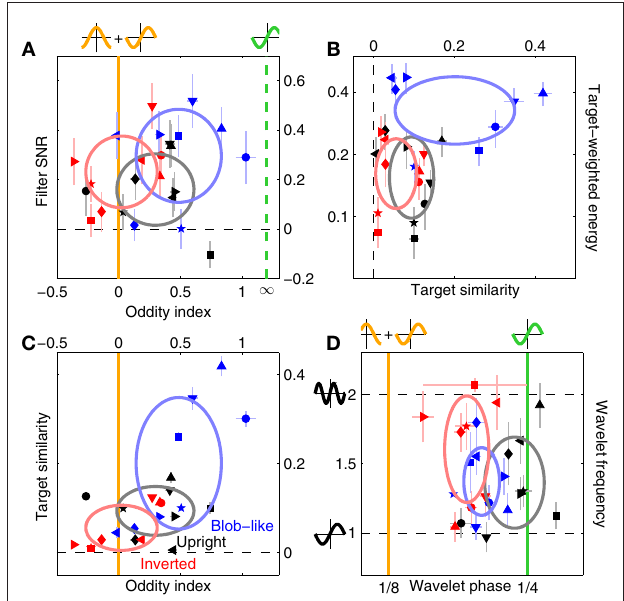
Figure 5 | Filter shape metrics. (A) Plots filter oddity (log-ratio between odd and even energy) on the x axis, versus filter signal-to-noise ratio (SNR) on the y axis (see Section 2.6 for definitions of these quantities). Vertical orange line indicates oddity index of 0, corresponding to equal odd and even content (see orange cosine + sine icon above line). Vertical green line indicates oddity index of ∞ , corresponding to a noiseless odd function (see green sine icon above line). Horizontal dashed line indicates filter SNR of 0, corresponding to noise baseline (filter containing only measurement noise). Ovals are centered on corresponding mean values and radius equals SD. (B) Plots target similarity (correlation between perceptual filter and target shape) on the x axis, versus energy of target-weighted filter on the y axis (see Section 2.6). (C) Plots oddity [from x axis in (A) ] on the x axis versus target similarity [from x axis in (B) ] on the y axis. (D) Plots phase ( x axis) and frequency ( y axis) parameters for the pseudo-Gabor fit (see Section 2.6). Orange and green lines indicate phase values somewhat connected to the lines in (A) , although oddity and phase are conceptually different quantities (see Section 2). Horizontal dashed lines indicate carrier frequencies of 1 and 2 cycles per degree (see sinusoidal icons to the left of